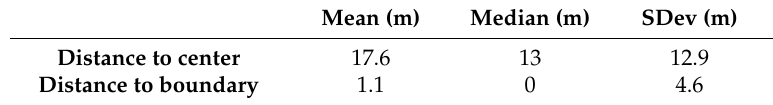
Table 5. Summary of the ATM locations in relation to building center and boundary.